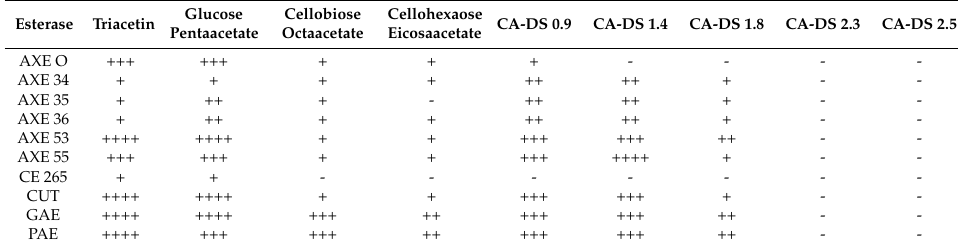
Table 1. Esterase screening for several esterases substrates. Very strong deacetylation (++++), strong deacetylation (+++), moderate deacetylation (++), weak deacetylation (+), no deacetylation (-). Axetyl xylan estarase (AXE); carbohydrate esterase (CE); cutinase (CUT); glucomannan acetyl esterase (GAE); ND pectin acetyl esterase